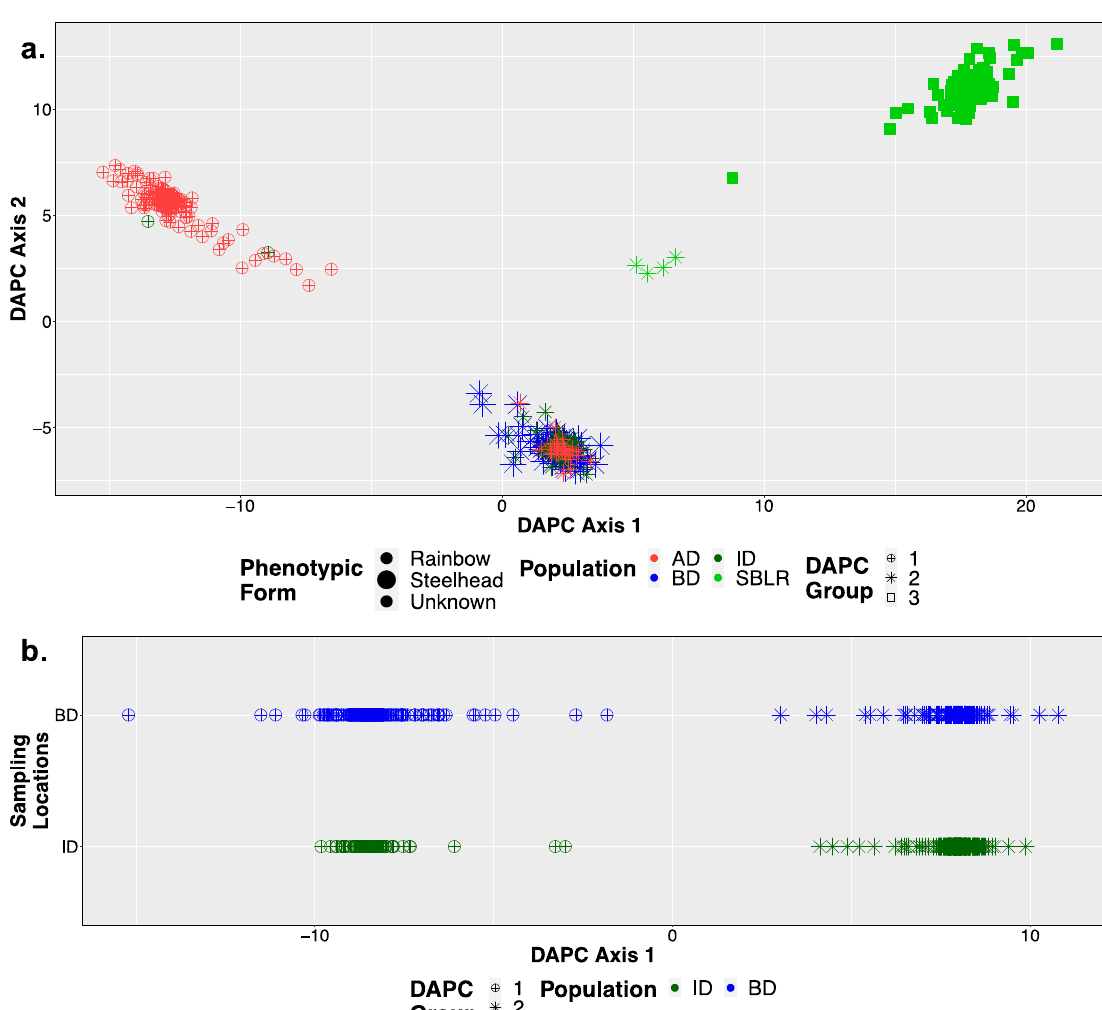
(Figure 3a). Post-dam removal, fastSTRUCTURE supported K = 2 with high levels of ad- mixture among all individuals sampled (Figure 3b).